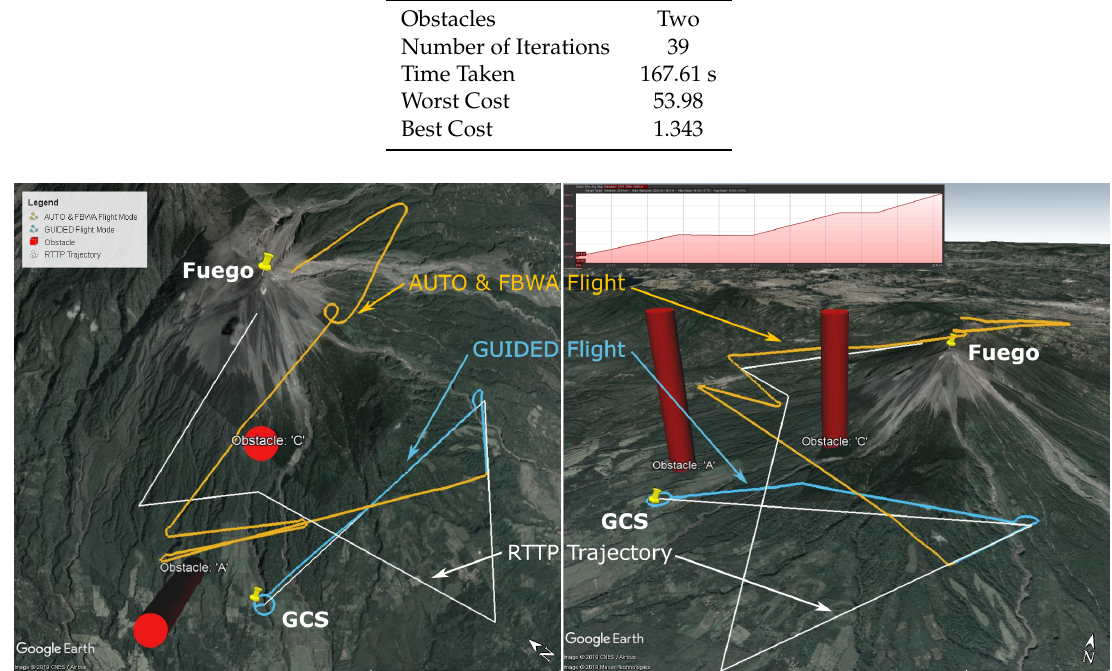
Figure 7. Flight C data: top down (left) and 3D (right) maps showing the Real Time Trajectory Planner solution (white) and the actual flight path (Guided: Blue, Auto/FBWA: Orange) in Google Earth [29]. Obstacles are shown by red cylinders, and the elevation profile of the RTTP Trajectory is inset (top, right).